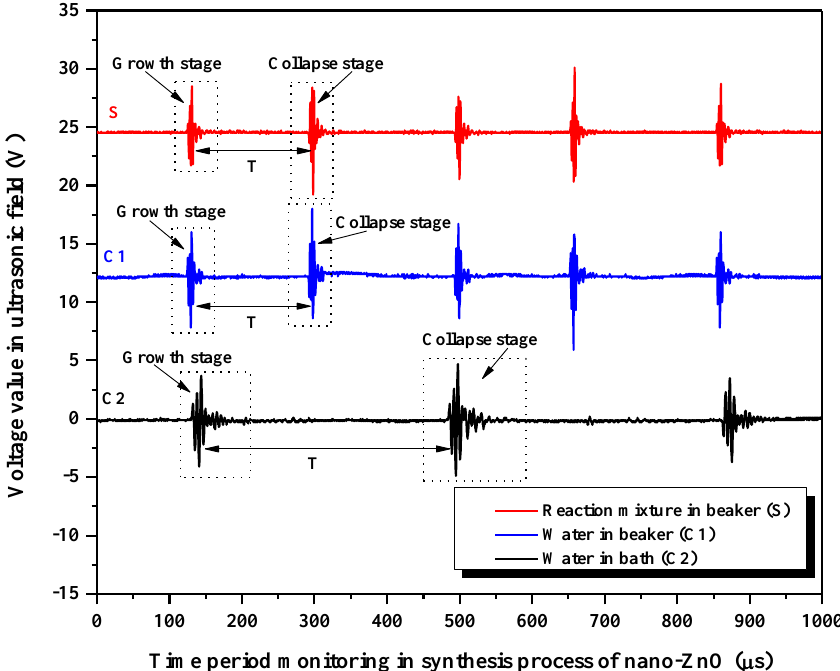
Figure 5. Cyclical fluctuations of voltage waveforms captured from the ultrasonic fields during the synthesis process of nano-ZnO.